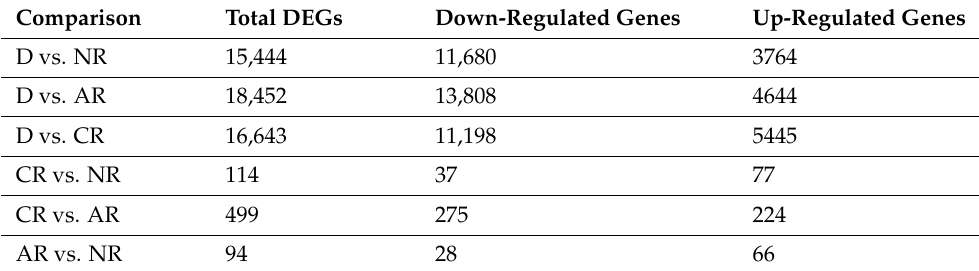
Table 2. Differential gene expression analysis [adjusted p -value (FDR) < 0.05: − 1.5 < Fold Change < +